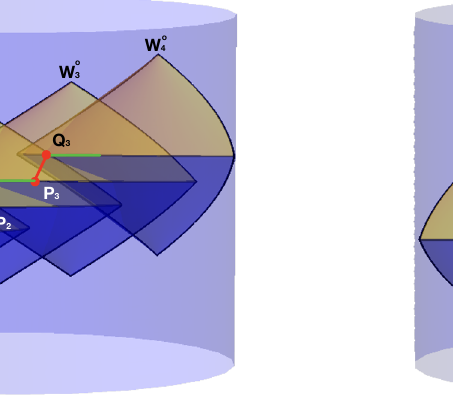
Figure 3 . How the same sequence of geodesics de(cid:12)nes a bulk curve using outgoing (left) and ingoing (right) lightsheets in the NVA condition. The green lines are pieces of geodesics (cid:21) and the red lines are null segments that join these pieces. In the continuum limit, the pieces of geodesics and lightrays become the bulk curve. The constructions with outgoing and ingoing lightsheets typically generate di(cid:11)erent bulk